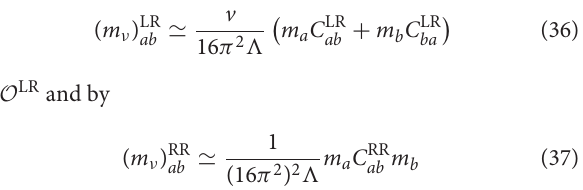
FIGURE 13 | Lowest order contributions of O LR ( left , at 1-loop order) and O RR ( right , at 2-loop order) to neutrino masses. The red dot indicates the 1 L effective vertex. Figure reproduced following del Aguila [